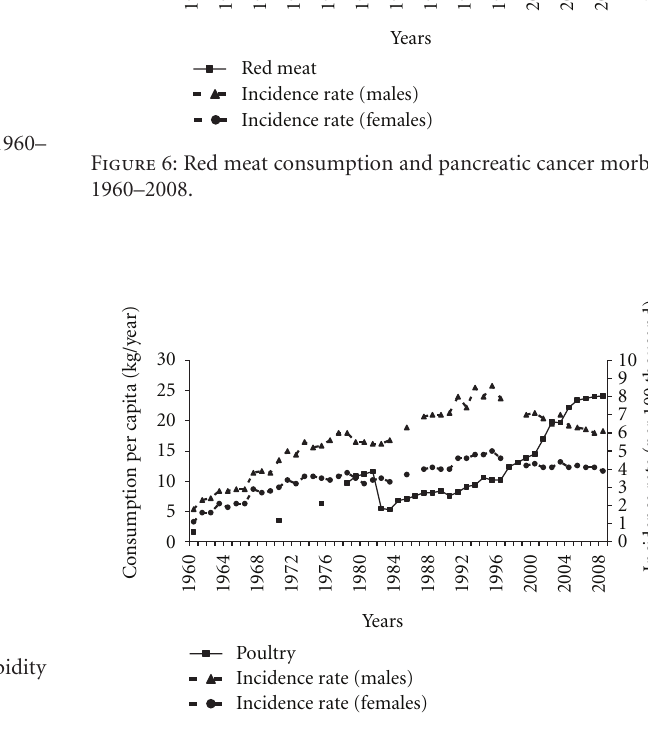
Figure 7: Poultry consumption and pancreatic cancer morbidity 1960–2008.